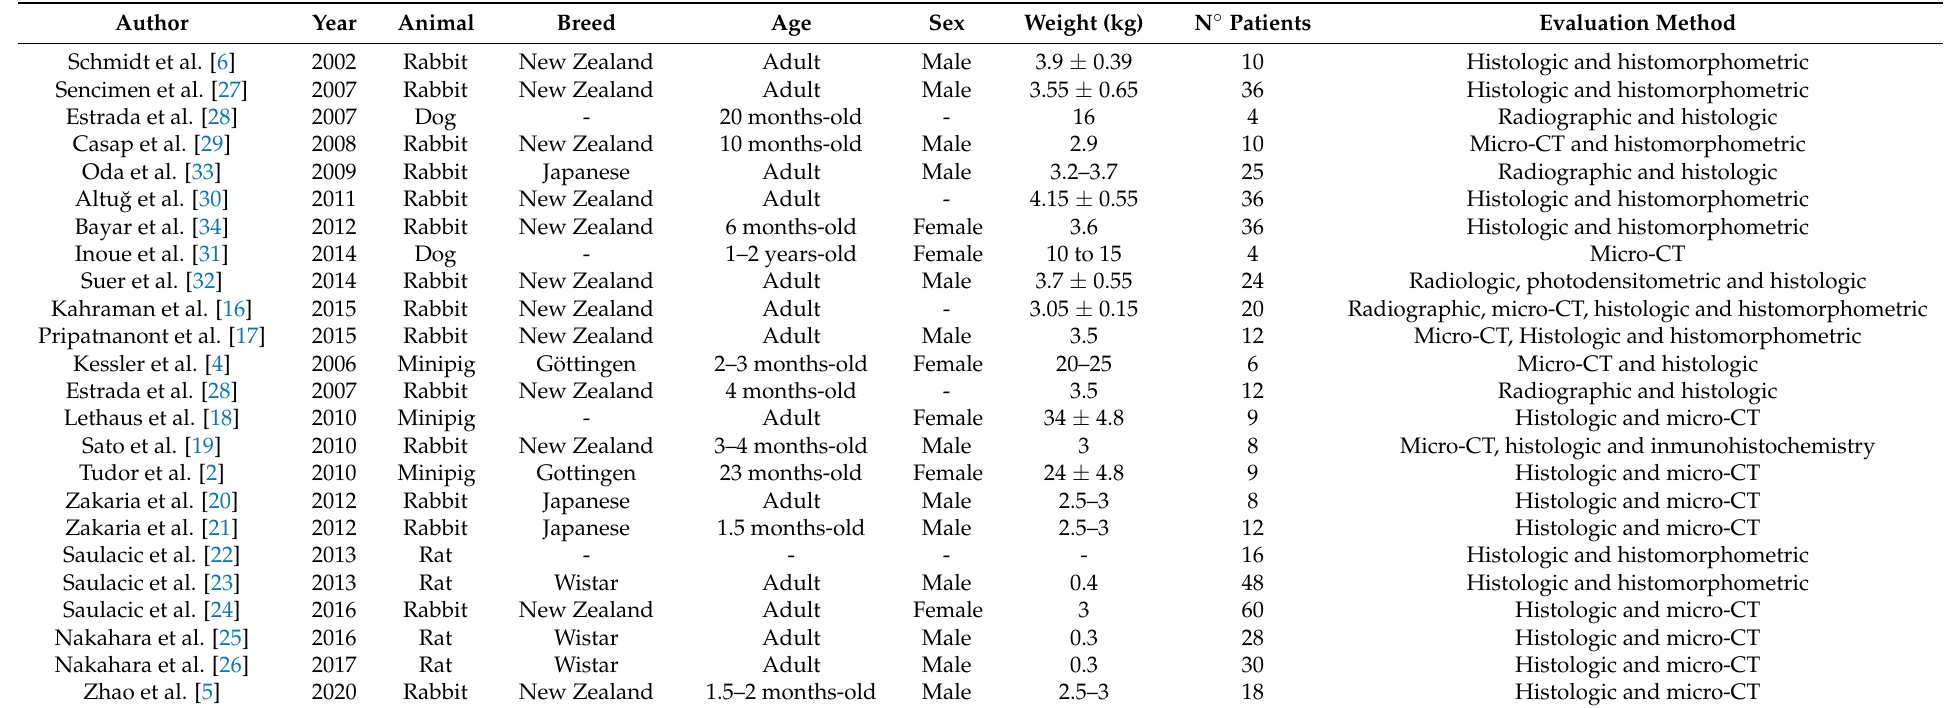
Table 1. Characteristics of the animal model and evaluation methods used by each